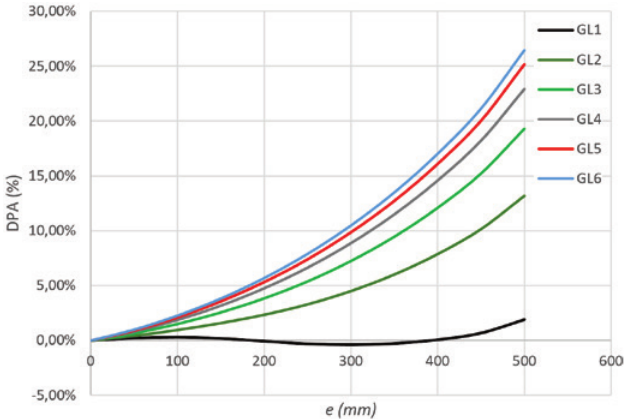
Figura 11 Curvas das diferenças percentuais acumuladas das 11 simulações dos modelos MP3DL1 a